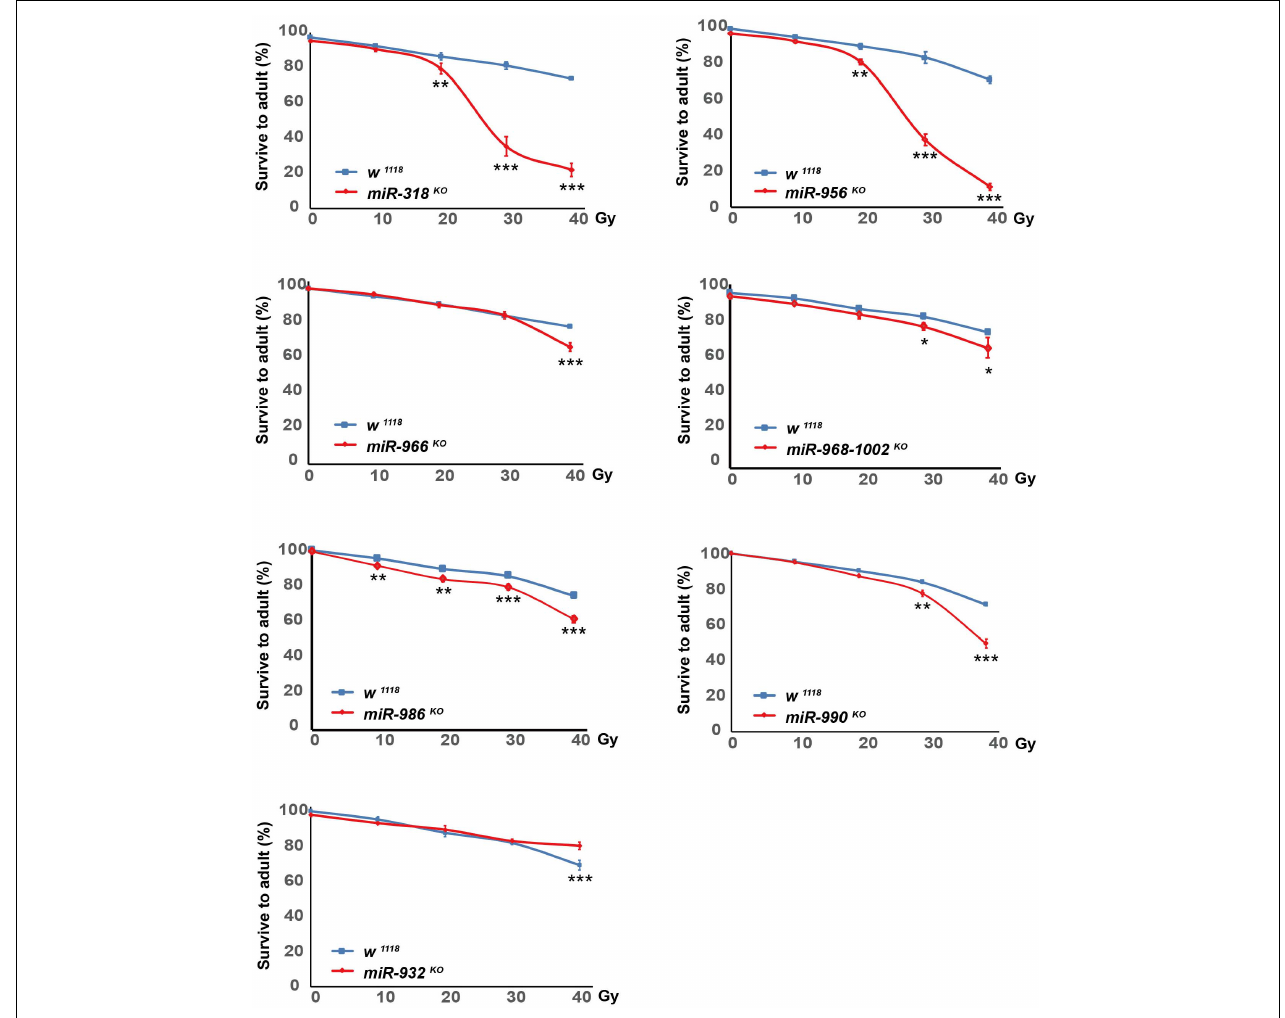
FIGURE 10 | Sensitivity of DE miRNAs mutants to X-ray irradiation. Late third instar larvae of w 1118 , miR-318 KO , miR-932 KO , miR-956 KO , miR-966 KO , miR-968-1002 KO , miR-986 KO and miR-990 KO flies were irradiated with dosage of 0, 10, 20, 30, and 40 Gy, respectively. Survival adults were counted, and survival percentage was calculated as number of viable adult flies divided by number of irradiated larvae. At least 100 larvae were treated at each dosage for each genotype, and three independent experiments were performed. * P ≤ 0.05, ** P ≤ 0.01, *** P ≤ 0.001; error bars indicate